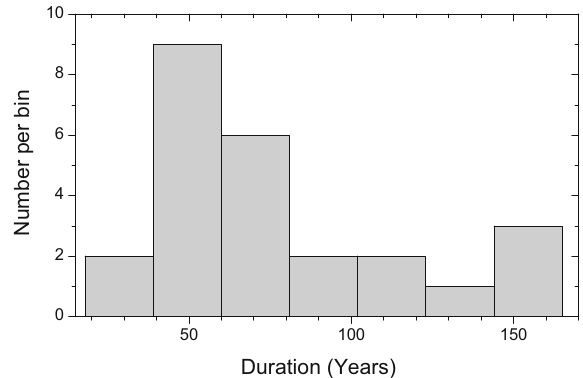
Fig. 22 Histogram of the duration of grand minima from Table